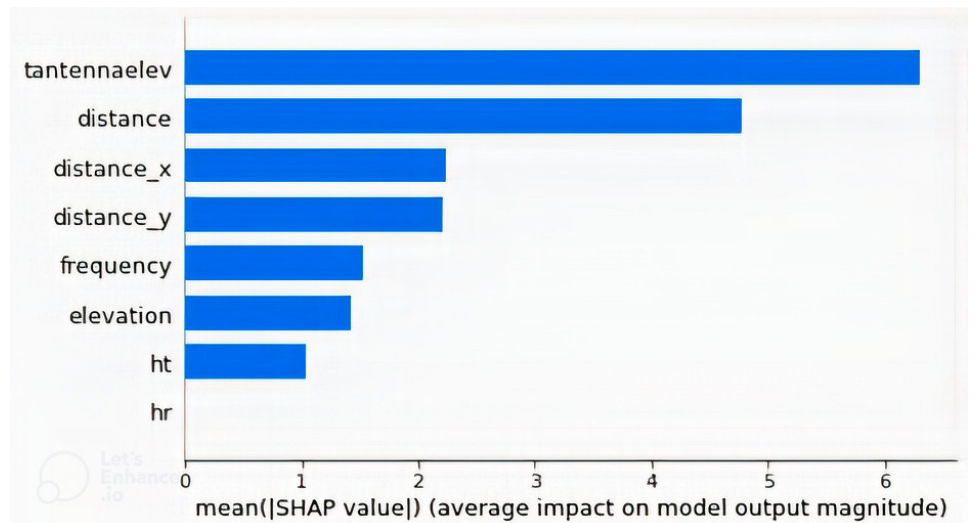
Figure 5. Mean feature importances of the model with non-image features only, with “tantennaelev” having the highest importance and “hr” the